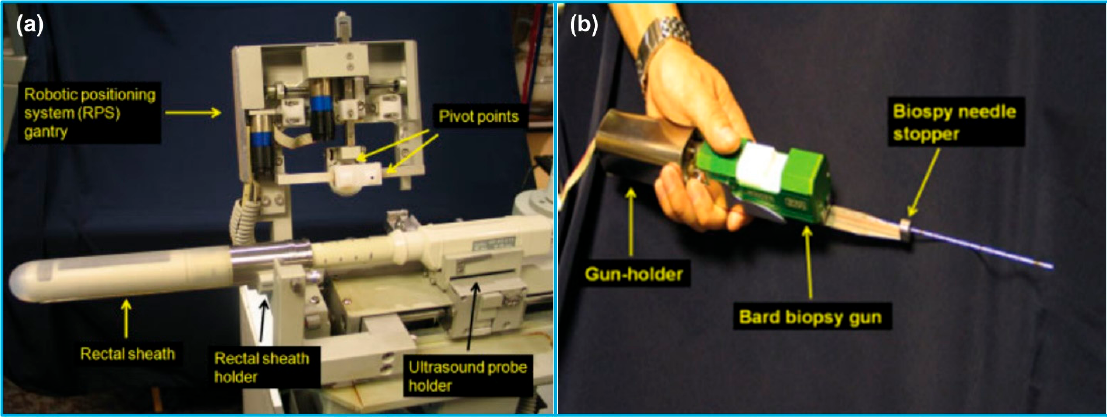
Figure 13. ( a ) Out-of-plane needle trajectory planning. ( b ) Schematic of the coordinate systems and needle movement. Reprinted from [167] with permission.